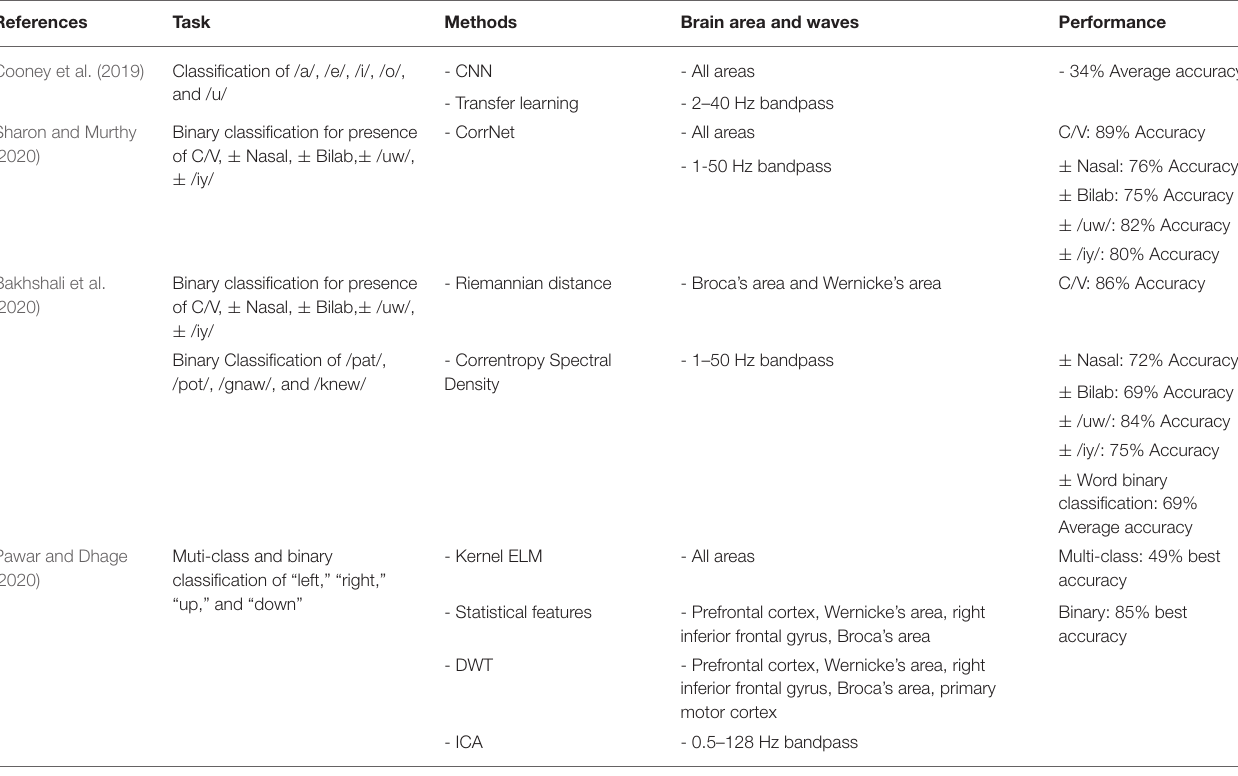
TABLE 5 | Imagined speech classification methods summary (continuation).